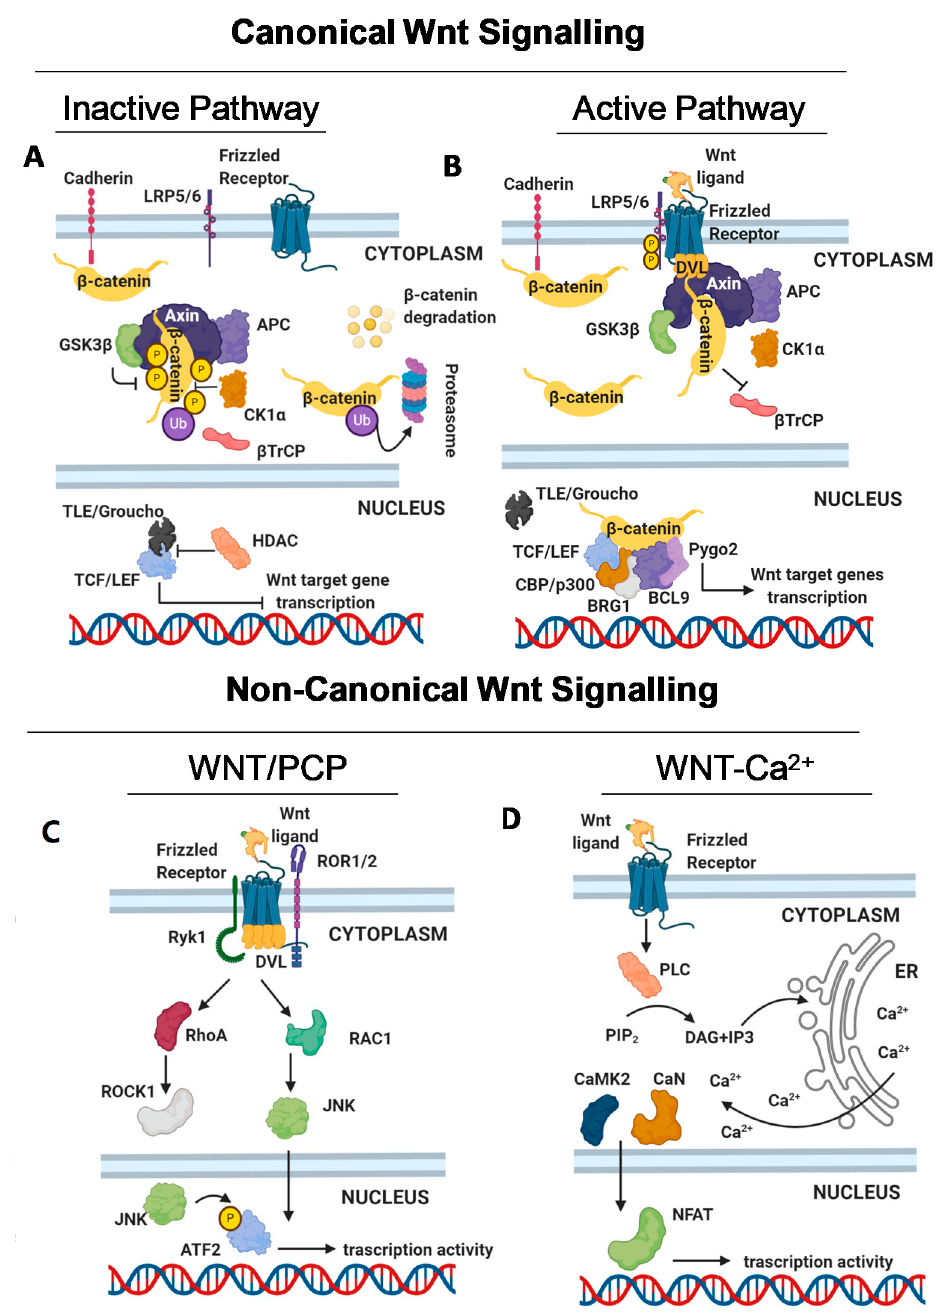
Figure 1. Overview of canonical and non-canonical Wnt signalling. (A) In the canonical inactive wingless/integrated (Wnt) pathway, the absence of WNT ligands triggers the phosphorylation of β -catenin via the destruction complex consisting of Axin, adenomatous polyposis coli (APC), and the two kinases glycogen synthase kinase 3 β (GSK3 β ) and casein kinase 1 α (CK1 α ). In this biological scenario, β -catenin is phosphorylated by GSK3 β and CK1 α , ubiquitinated by β -transducin ( β -TrCP), and targeted for proteasomal degradation, which impairs its nuclear translocation. In the absence of nuclear β -catenin, a repressive complex, consisting of T-cell factor/lymphoid enhancer factor (TCF/LEF) and transducin-like enhancer of split (TLE)/Groucho, recruits histone deacetylase (HDAC) to halt Wnt target gene transcription. (B) The canonical active Wnt pathway is activated upon binding of WNT ligands to 15 Frizzled (FZD) receptors and LRP5/6 co-receptors. In this state, the destruction complex is recruited to the WNT/receptor complex and inactivated via the dissociation of all its components. This allows the stabilization and accumulation of cytoplasmic β -catenin, which then translocates into the nucleus where it forms an active complex with T-cell factor/lymphoid enhancer factor (TCF/LEF) proteins by displacing TLE/Groucho complexes. Histone modifying co-activators, such as CREB-binding protein (CBP)/p300, Brahma Related Gene 1 (BRG1), B-cell CLL/lymphoma 9 (BCL9) and Pypgpus family PHD finger2 (Pygo2), are recruited, thus allowing the transcription of the Wnt target genes. (C) In non-canonical Wnt/planar cell polarity (PCP) signalling, WNT ligands bind to the Receptor Tyrosine Kinase Like Orphan Receptor (ROR)/FZD complex, thus recruiting and activating Dishevelled (DVL). This triggers activation of the small GTPases Ras homolog family member A (RhoA) and Ras-related C3 botulinum toxin substrate 1 (RAC1), which in turn activate Rho Associated Coiled-Coil Containing Protein Kinase (ROCK) and c-Jun N-terminal Kinase (JNK), leading to rearrangements of the cytoskeleton and transcriptional program via activating transcription factor 2 (ATF2). (D) Wnt/Ca2 + signalling is initiated by G-protein triggered phospholipase C (PLC), which converts phosphatidylinositol 4,5-bisphosphate (PIP2) into diacylglycerol (DAG) and inositol trisphosphate (IP3). This leads to intracellular calcium fluxes and, in turn, activation of calmodulin kinase 2 (CaMK2) and calcineurin (CaN) proteins to induce downstream calcium-dependent cytoskeletal modifications and transcriptional activity via the activating factor nuclear factor of activated T-cell (NFAT). While the complex consisting of Wnt, FZD, and LRP proteins activates the canonical Wnt/ β -catenin-dependent signalling cascade (Figure 1A,B), the complex formed by FZD and/or Receptor Tyrosine Kinase Like Orphan Receptor 1/ Receptor Tyrosine Kinase Like Orphan Receptor